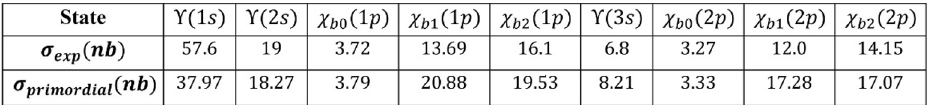
Table 1 . The experimentally observed ( σ exp ) and primordial ( σ primordial ) pp → bottomonium production cross sections of the various bottomonium states. Data were collected from refs. [63, 69– 75]. The primordial (direct) cross-sections were obtained from the experimentally measured post feed down cross sections using, ~σ = F − 1 ~σ primordial exp